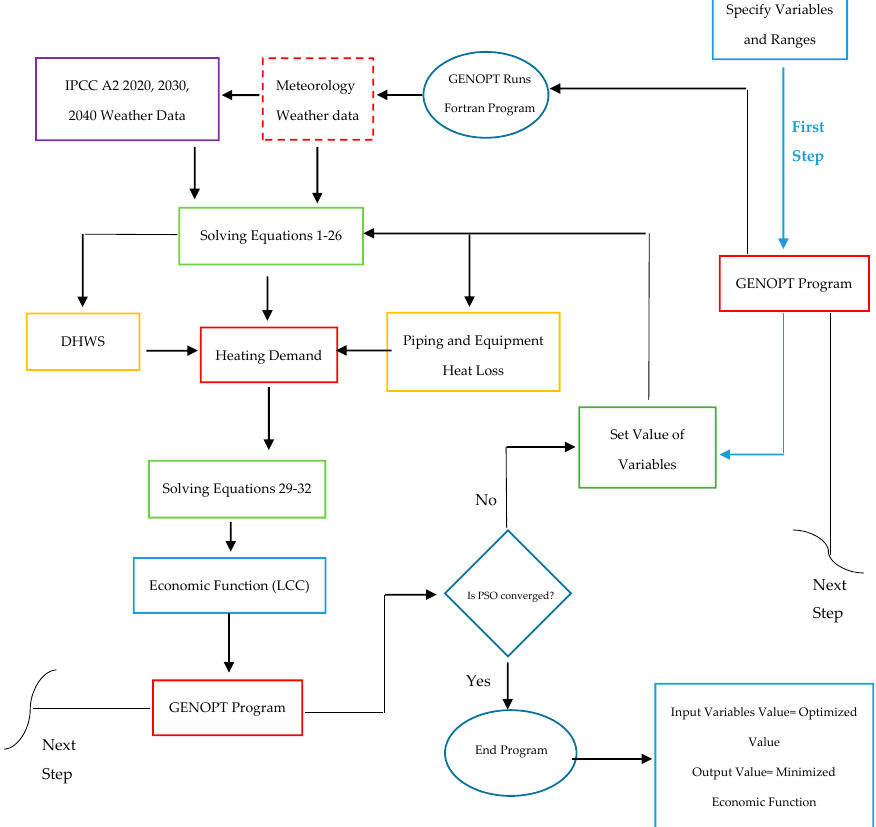
Figure 12. Schematic flowchart of the Particle Swarm Optimization (PSO) optimization method. Parameters values for PSO method has been gained from Almeida et al. [39], as presented in Table 7. Table 7. PSO method with constriction coefficient parameters.